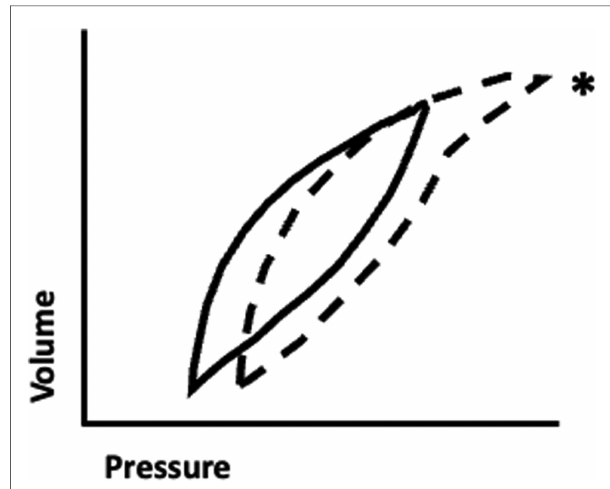
FIGURE 1 Pressure-volume loop demonstrating the phenomenon of “ beaking. ” A typical pressure-volume loop generated from ventilation of an optimally-expanded lung (solid line) is shown for reference. Note that in the normal condition, a relatively small change in pressure results in a signi fi cant change in volume. Excessive positive end expiratory pressure can result in ventilation of a hyperin fl ated lung (dashed line), and as tidal volume nears total lung capacity it requires a higher change in pressure and a higher peak pressure to attain a similar change in volume. The fl attening of the upper portion of the curve is referred to as “ beaking ”